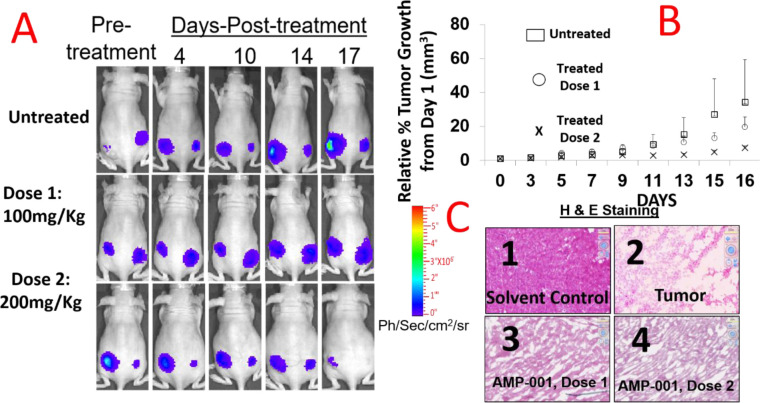
AMP-001 monotherapy treatment in TNBC mouse model results in reduced tumor growth and size.Mice (n = 8/group were injected i.p with AMP-001 and the tumor regression was monitored through Bioluminescent Imaging signal (A) and tumor volume measurement, P <0.05, (B). Schedule: Three times a week for two weeks. Change in tumor volume for treated tumor as a percentage of tumor growth (C) H&E staining was performed on non-target organ heart specimens to demonstrate intactness of cellularity (C-3 & C4) or destruction of tissue structure in tumor respectively (C2) compared to untreated control (C1), C: 2–4 Magnification X 400, n = 5, p < 0.001.